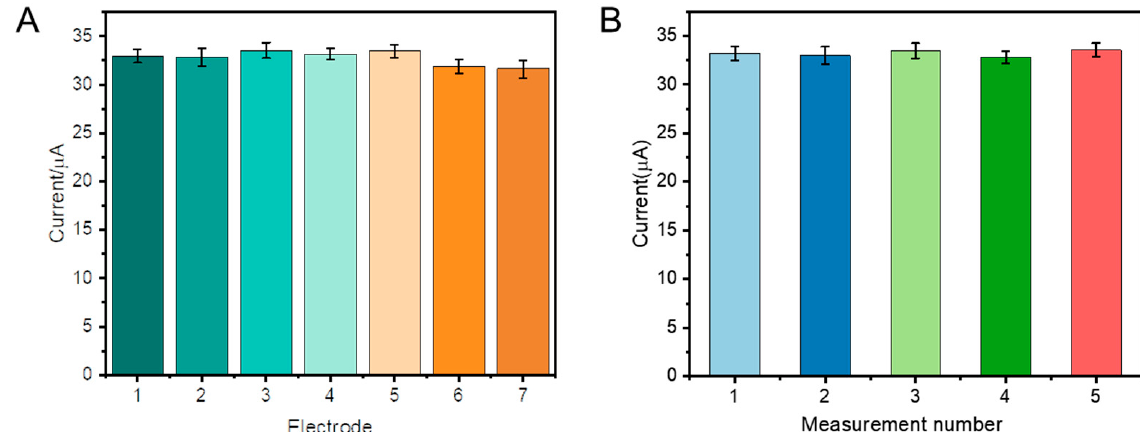
Figure 4. ( A ) DPV current values obtained by seven different electrodes in 1 µ M rutin; ( B ) DPV current values obtained by five repeated tests in 1 µ M rutin.